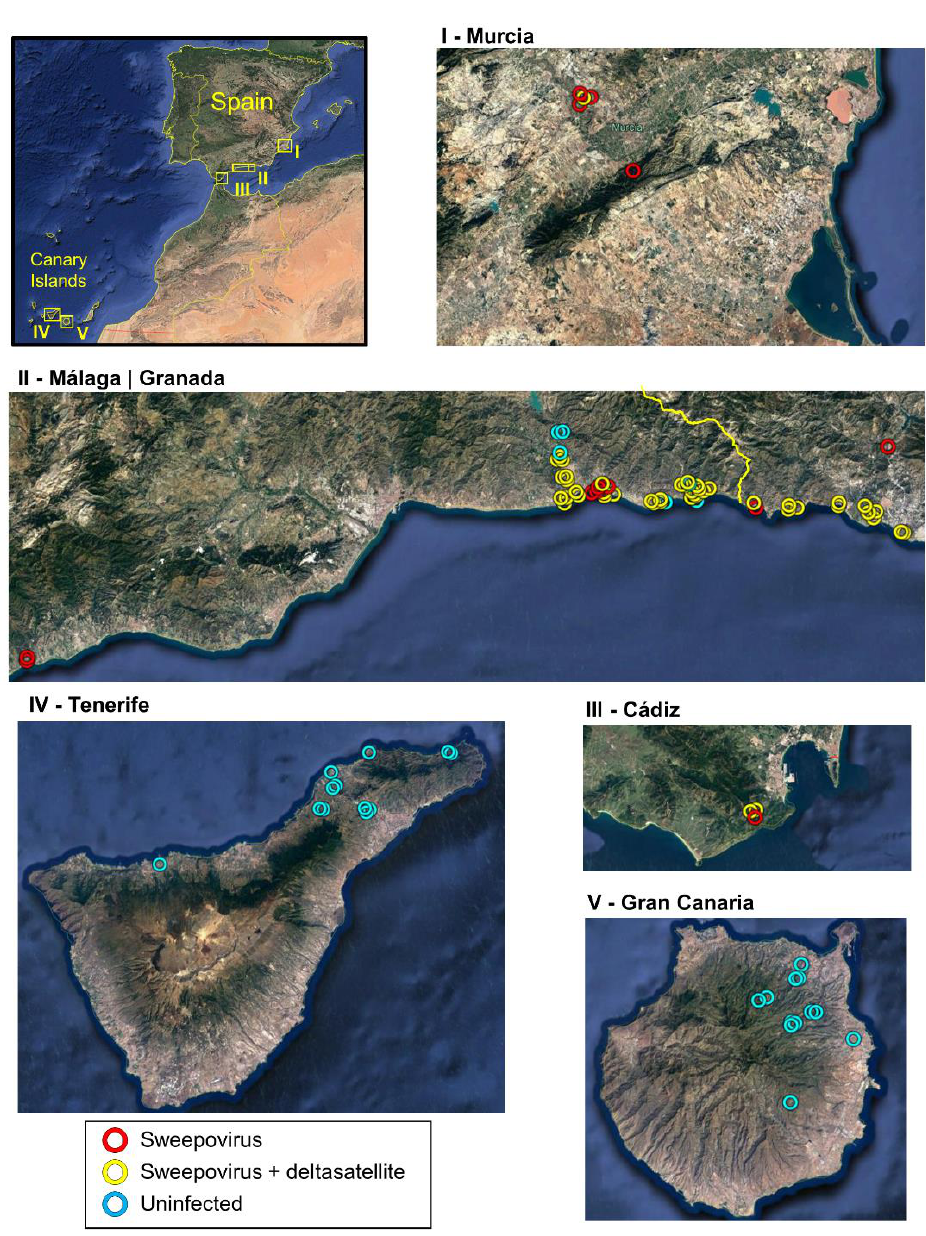
Figure 1. Maps showing the locations of the Ipomoea indica plants sampled in southern continental Spain (Murcia ( I ), Granada ( II ), Málaga ( II ), and Cádiz ( III ) provinces) and the Canary Islands (Tenerife ( IV ) and Gran Canaria ( V )) and analyzed in this work. Samples infected with sweepoviruses (red circles), sweepoviruses plus deltasatellites (yellow circles), and uninfected (blue circles) are indicated in the images.